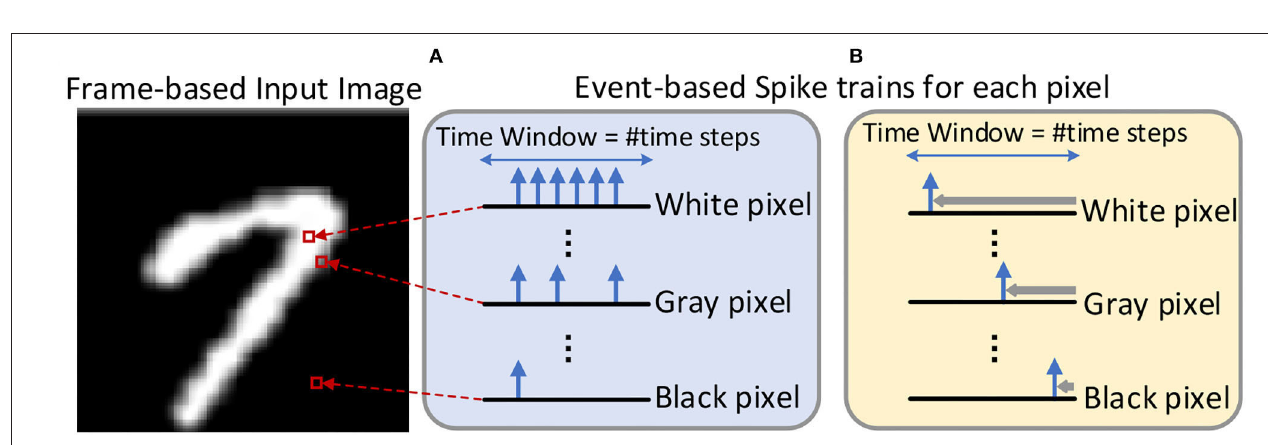
FIGURE 3 | An example about the input image is converted into the input spike train by the (A) rate-based coding scheme (Han et al., 2020) and (B) Time-To-First-Spike time-based coding scheme ( Rathi et al., 2020). The time window represents the length of the spike train, which is equal to the number of time